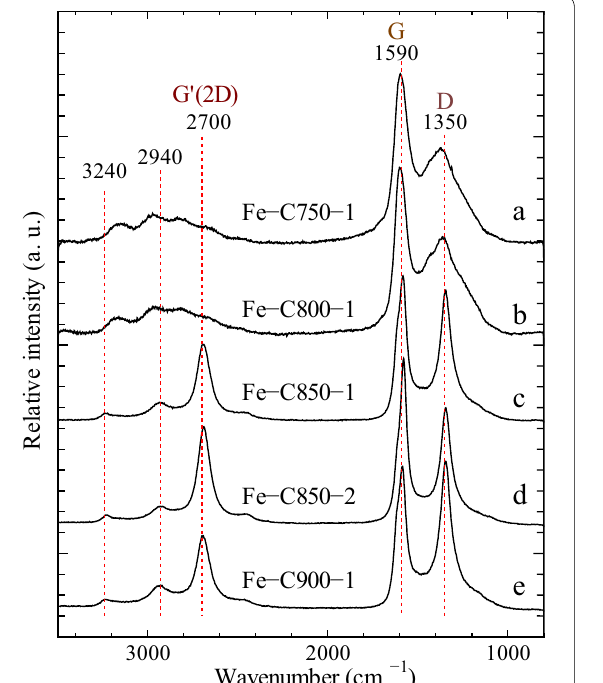
Fig. 1 Typical Raman spectra of iron-loaded charcoal samples: a Fe-C750-1; b Fe-C800-1; c Fe-850–1; d Fe-C850-2; e Fe-C900-1